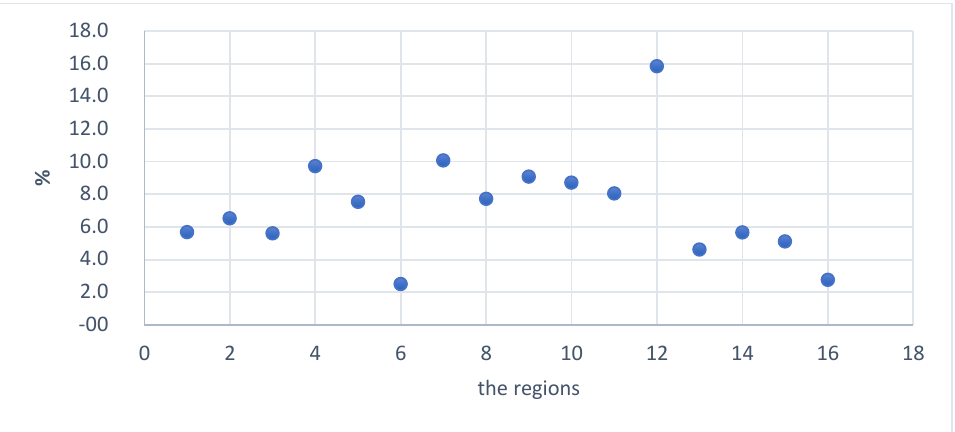
Figure 2. Distribution of the average share of energy costs across the republic (%). Source: personal elaboration.